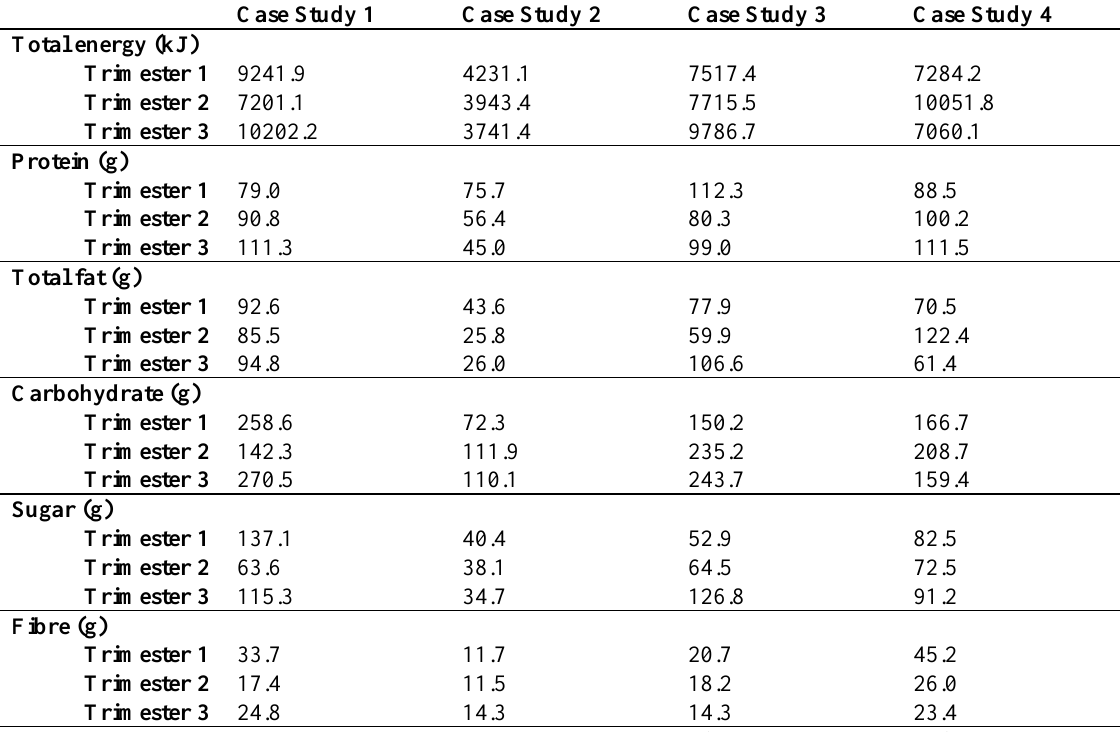
Table 2-A1: Dietary recall